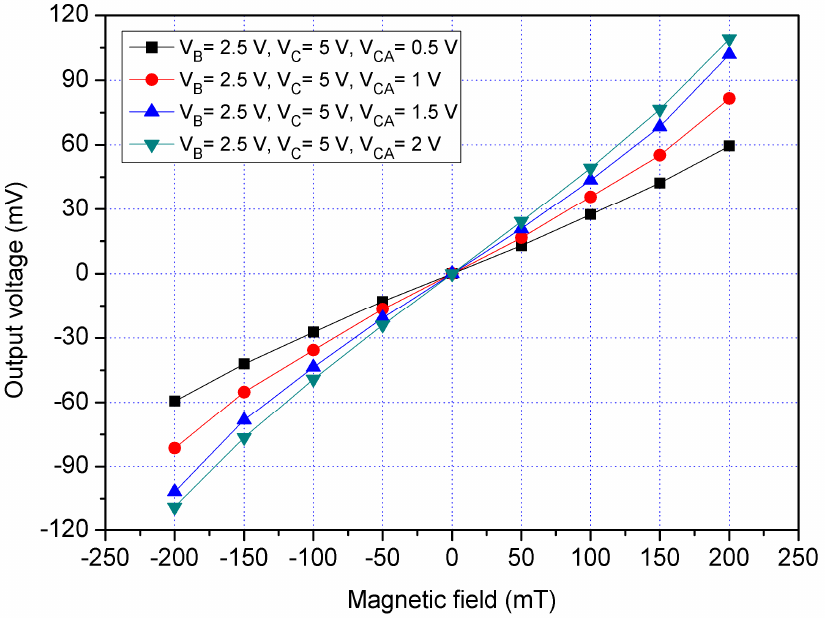
Figure 15. Measured Vo for the x/y-MSE with bias of the additional collectors in the y-direction MF. The z-MSE characteristic was tested in the z-direction MF. The MF generator